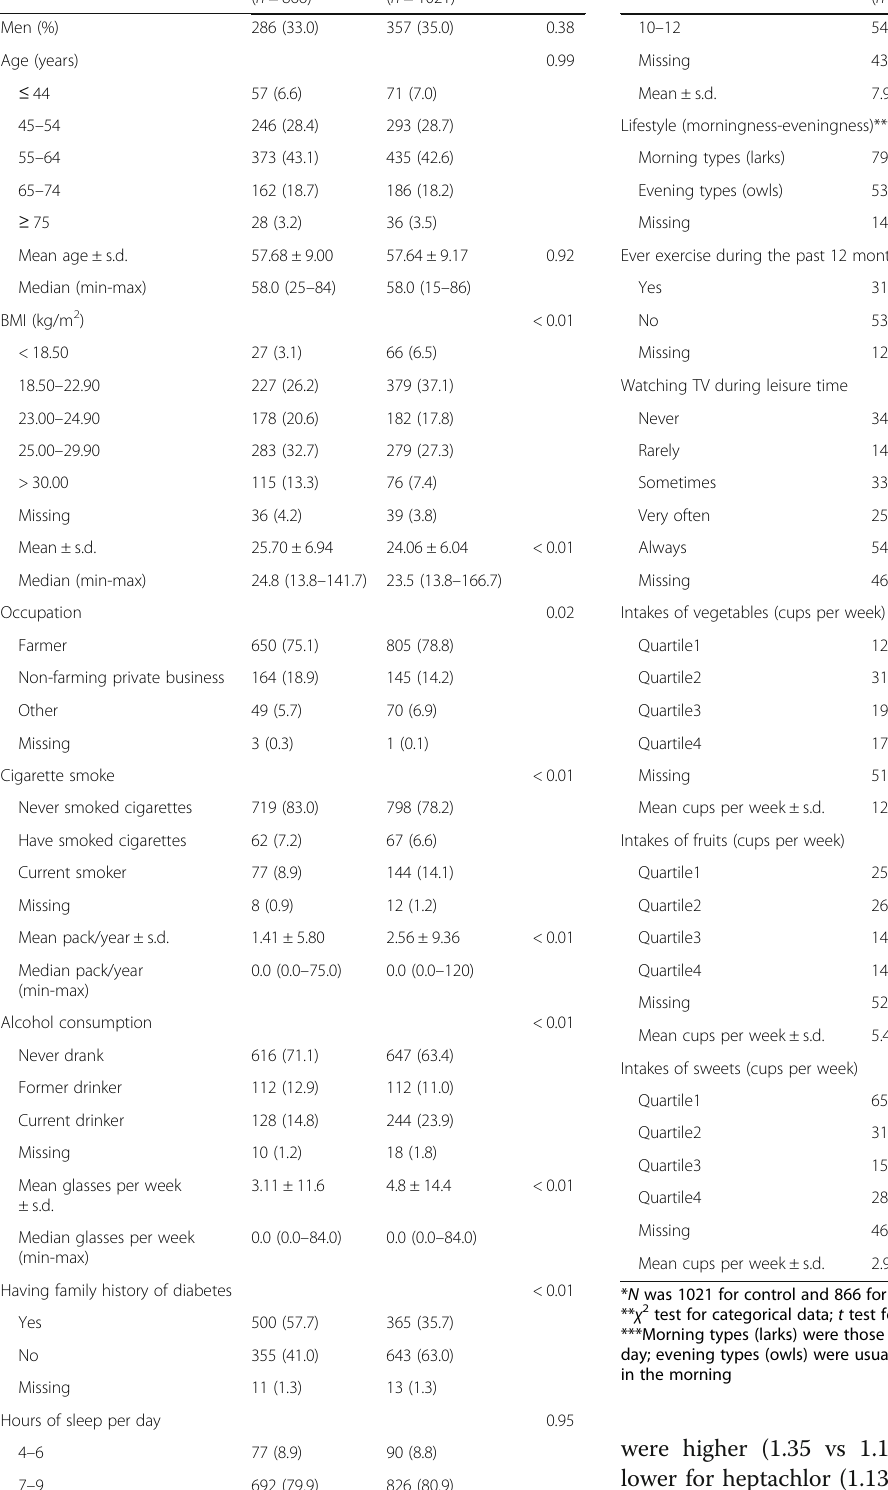
Table 1 General characteristics and variables between case and control groups